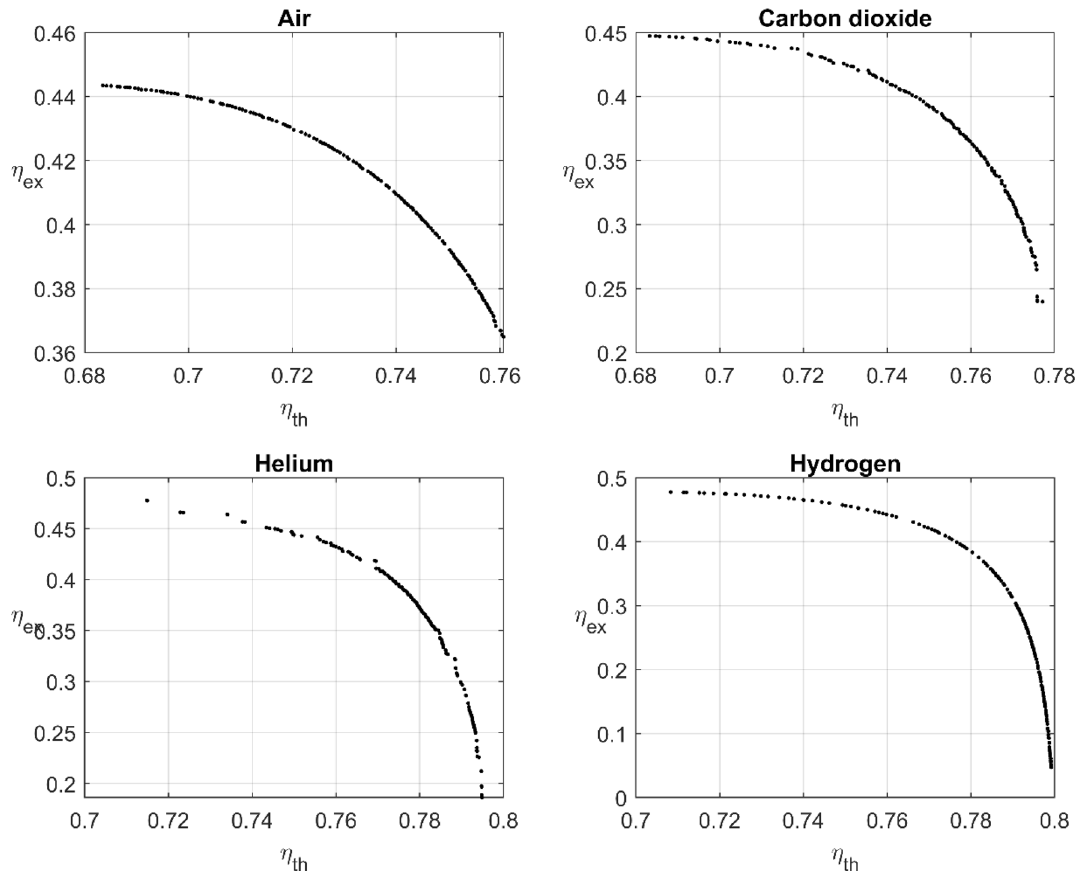
Figure 7. Pareto fronts of the gas thermal